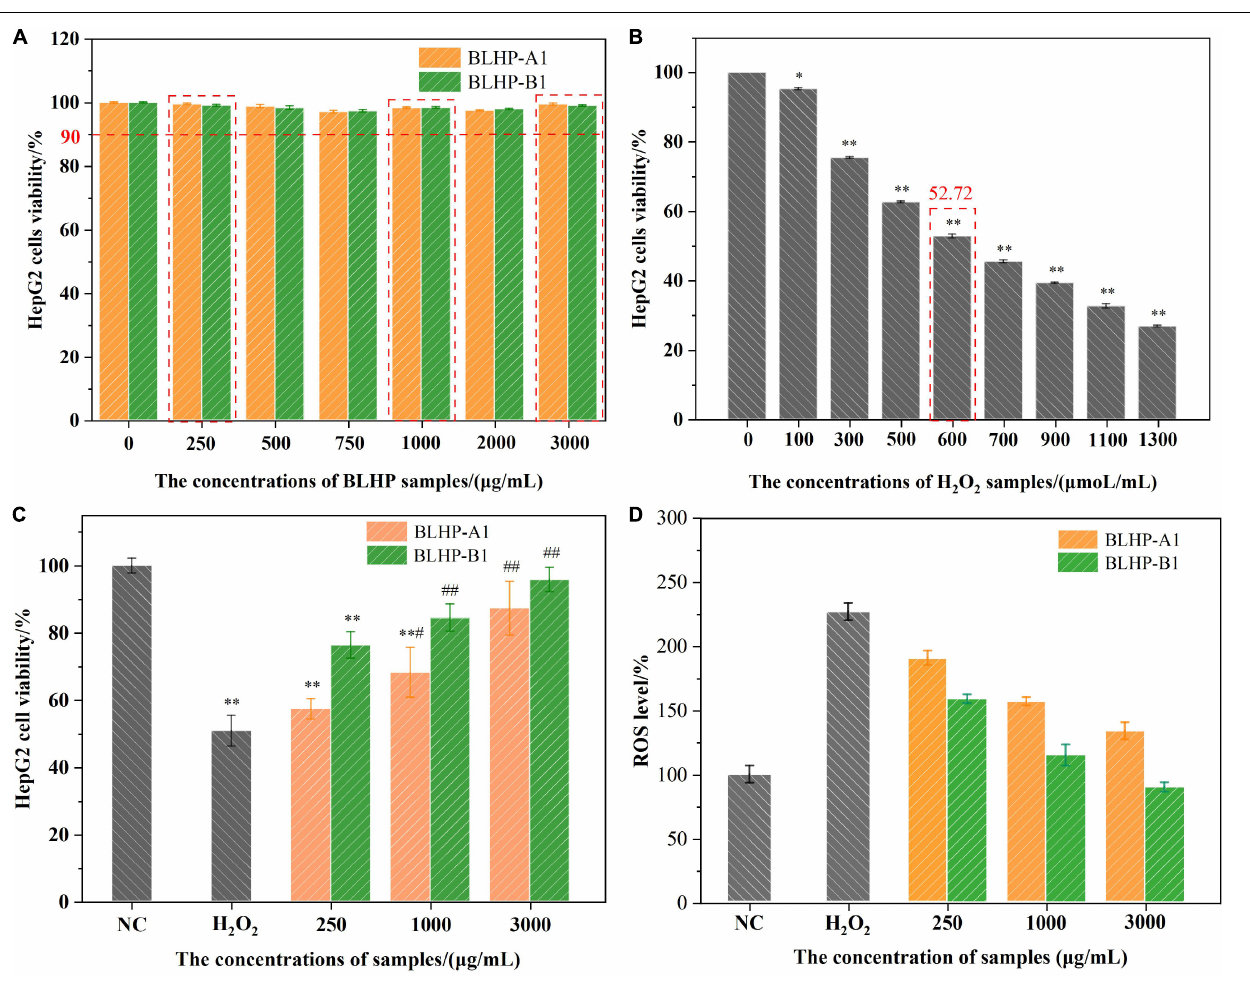
FIGURE 7 | The effects of BLHP and H 2 O 2 concentrations on HepG2 cells viability. (A) The HepG2 cells were incubated with BLHP samples at different concentrations (0, 250, 500, 750, 1,000, 2,000, and 3,000 µ g/ml). (B) The HepG2 cells were treated with H 2 O 2 at different concentrations (0, 100, 300, 500, 600, 700, 900, 1,100, and 1,300 µ mol/ml). (C) The treated concentrations of H 2 O 2 , BLHP samples in the oxidative stress model. (D) Variations in relative ROS levels compared to that of NC group. The selected concentration of H 2 O 2 was 600 µ moL/ml. The selected concentrations of BLHP samples were 250, 1,000 and 3,000 µ g/ml. ( ∗ p < 0.05, ∗∗ p < 0.01 compared with the control group; # p < 0.05, ## p < 0.01 compared with the H 2 O 2 group).